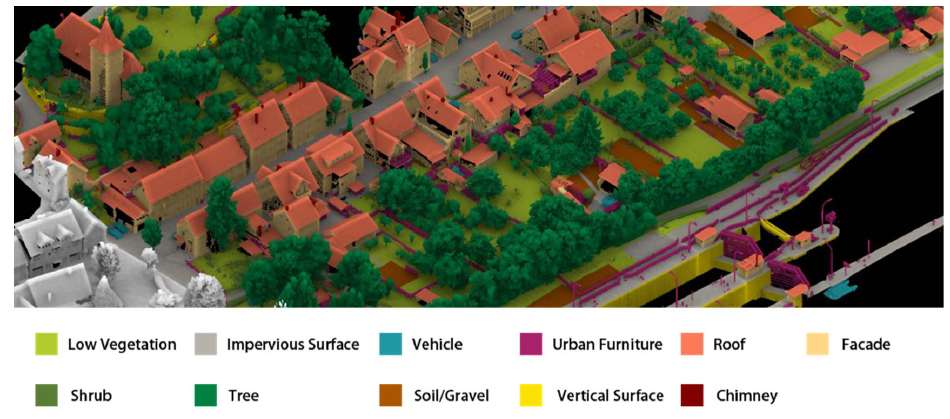
Figure 5. Hessigheim 3D Dataset [63].